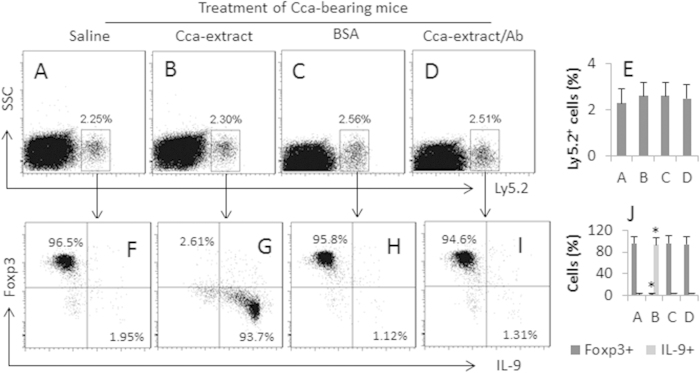
Cca-specific immune response converts Tregs to Th9 cells in Cca-bearing mice.A Cca model was created with Ly5.1 and Ly5.2 mice. The Cca-bearing mice were immunized with Cca extracts. CD4+ CD25+ CD127− Tregs were isolated from Ly5.2 mice by MACS (purity >98%) and transferred to Cca-bearing Ly5.1 mice on the day of immunization at 106 cells/mouse via tail vein injection. The mice were sacrificed on day 14. Single cells were prepared from the excised Cca tissue and analyzed by flow cytometry. A–D, the gated dot plots indicate the frequency of Ly5.2 cells. E, the bars indicate the summarized data of A–D. F–I, the dot plots indicate the frequency of Foxp3+ Tregs and IL-9+ cells. J, the bars indicate the summarized data of F–I. The data of bars are presented as mean ± SD. *, p < 0.01, compared with group A. Each group consisted of 6 mice. Samples from individual mice were processed separately. The data are representatives of 6 independent experiments.